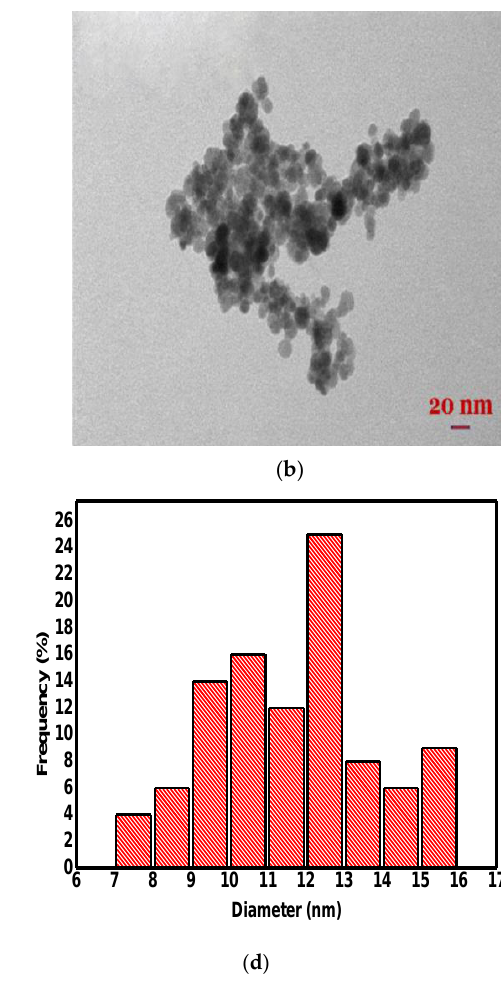
Figure 2. TEM images of Fe 3 O 4 nanoparticles ( a ), Fe 3 O 4 /CS nanocomposite ( b ), Fe 3 O 4 /CS/PEI nanocomposite ( c ), and the particle size distribution of the nanocomposite Fe 3 O 4 /CS/PEI ( d ).